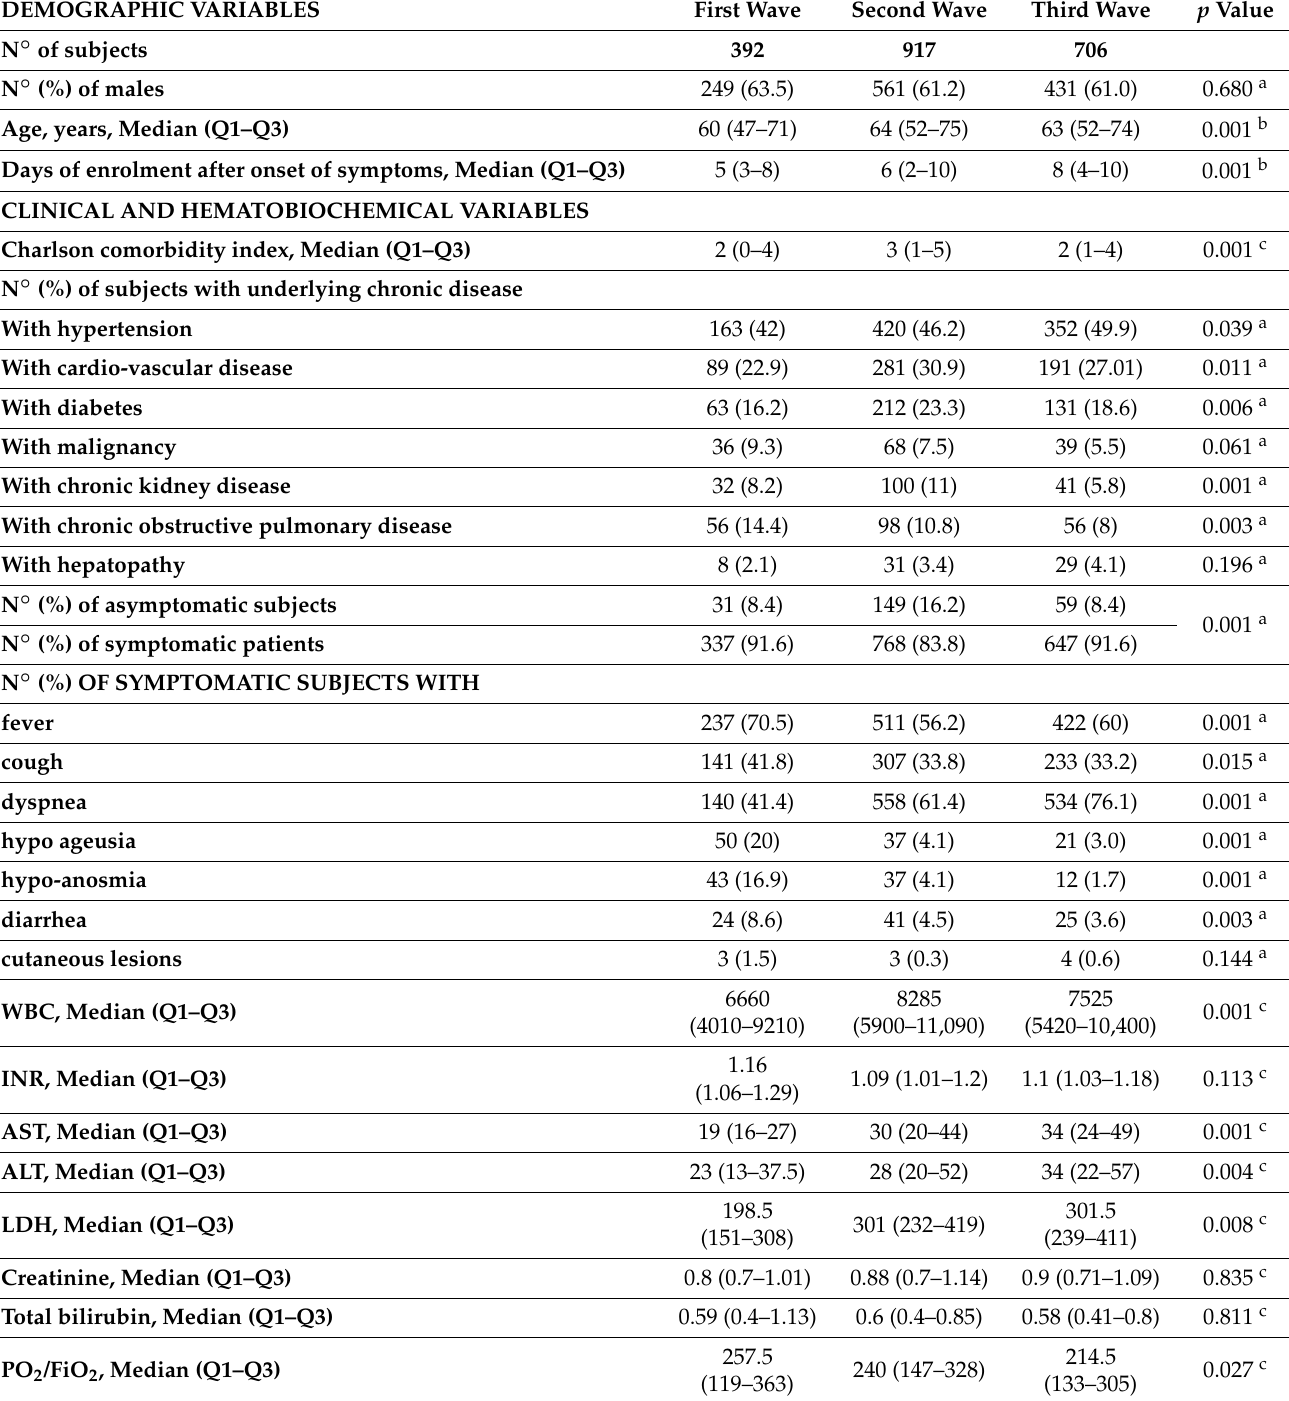
Table 2. Demographic, clinical and hematobiochemical data of patients included, divided by period of